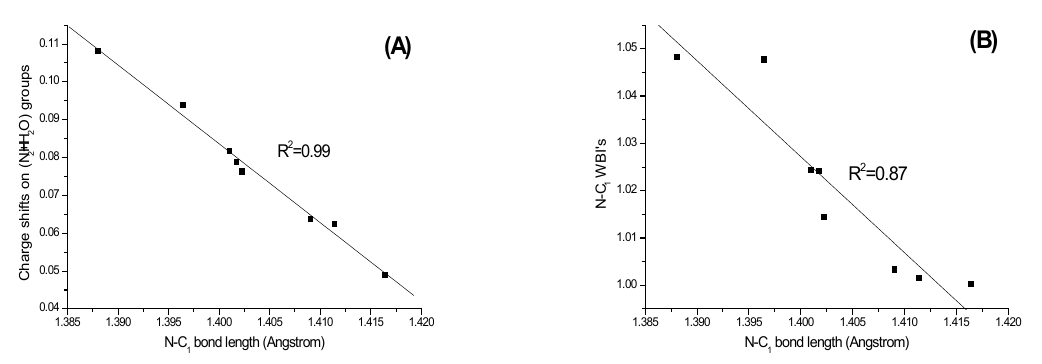
Figure 8. Various correlations among the N-C